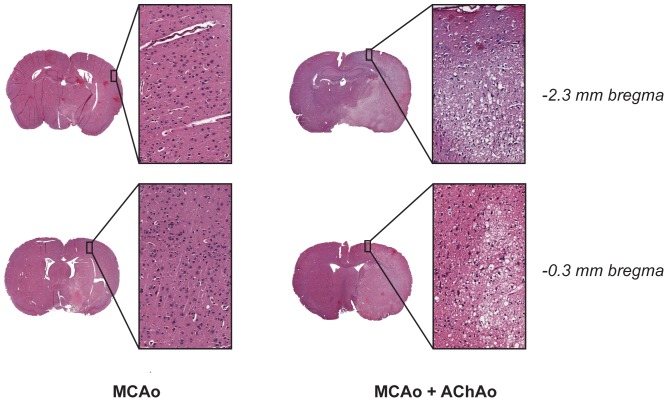
Histology sections from two pMCAo rats 24 h after stroke.Hemotoxylin-eosin stained coronal sections scanned at 20x objective. The animal with the MCAo + AChAo (right column) had prominent subcortical and cortical infarction (pyknotic, dark, shrunken nuclei: expanded regions-of-interest); the animal with MCAo alone (left column) had subcortical infarction, but no infarction within similar cortical locations.